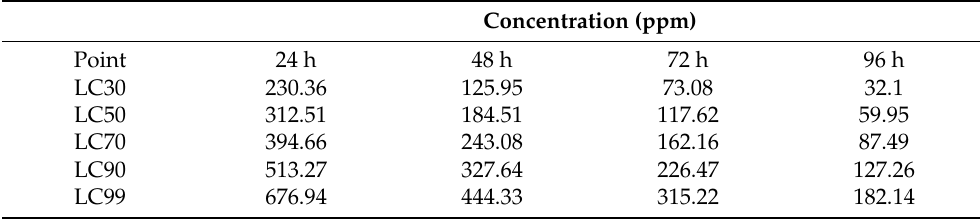
Table 1. Lethal concentrations of commercial ZnO-NPs at different time points of 24, 48, 72, and 96